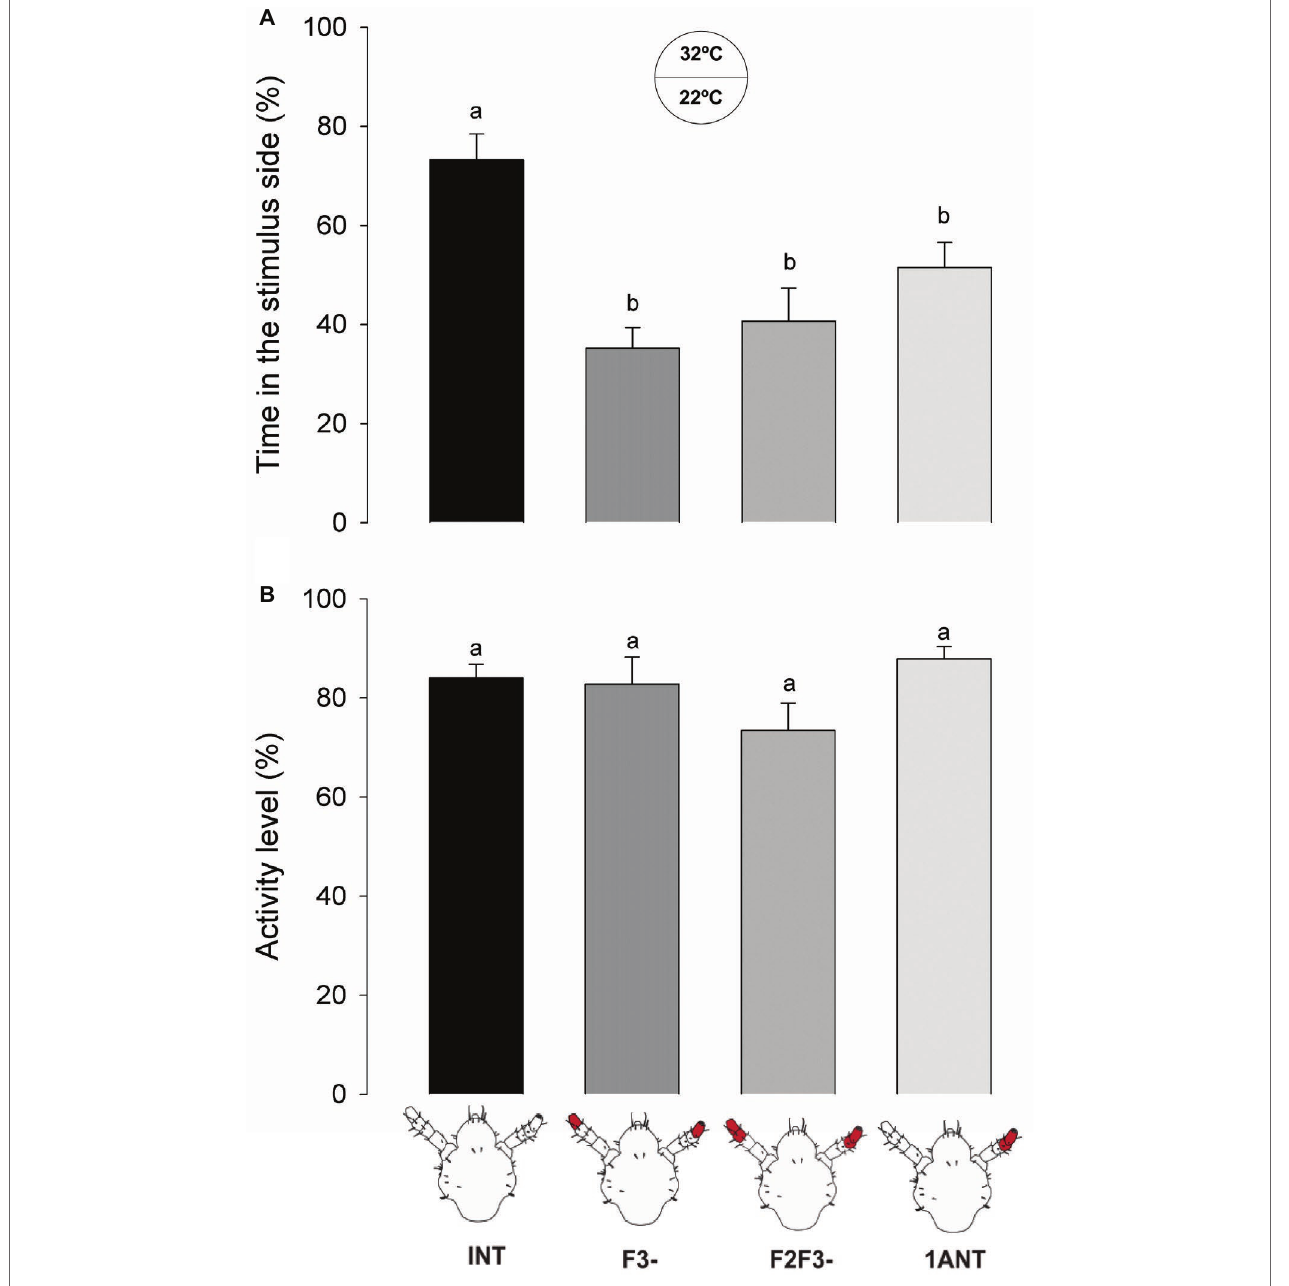
FIGURE 5 | Behavioral responses of intact and antennectomized head lice to a warm substrate. (A) Thermal preference of intact and antennectomized lice in a two-choice arena, measured as the percentage of the time spent at the heated (32 ° C) side. INT lice spent significantly more time in the warmer side of the arena than all antennectomized ones ( F3- , F2F3- , and 1ANT ). (B) Activity levels of intact and antennectomized head lice, measured as the percentage of the experimental time they remained active over the arena. All groups displayed similar activity levels. Each column represents the mean of 15 insects. Different letters indicate significant differences (one-way ANOVA, p <